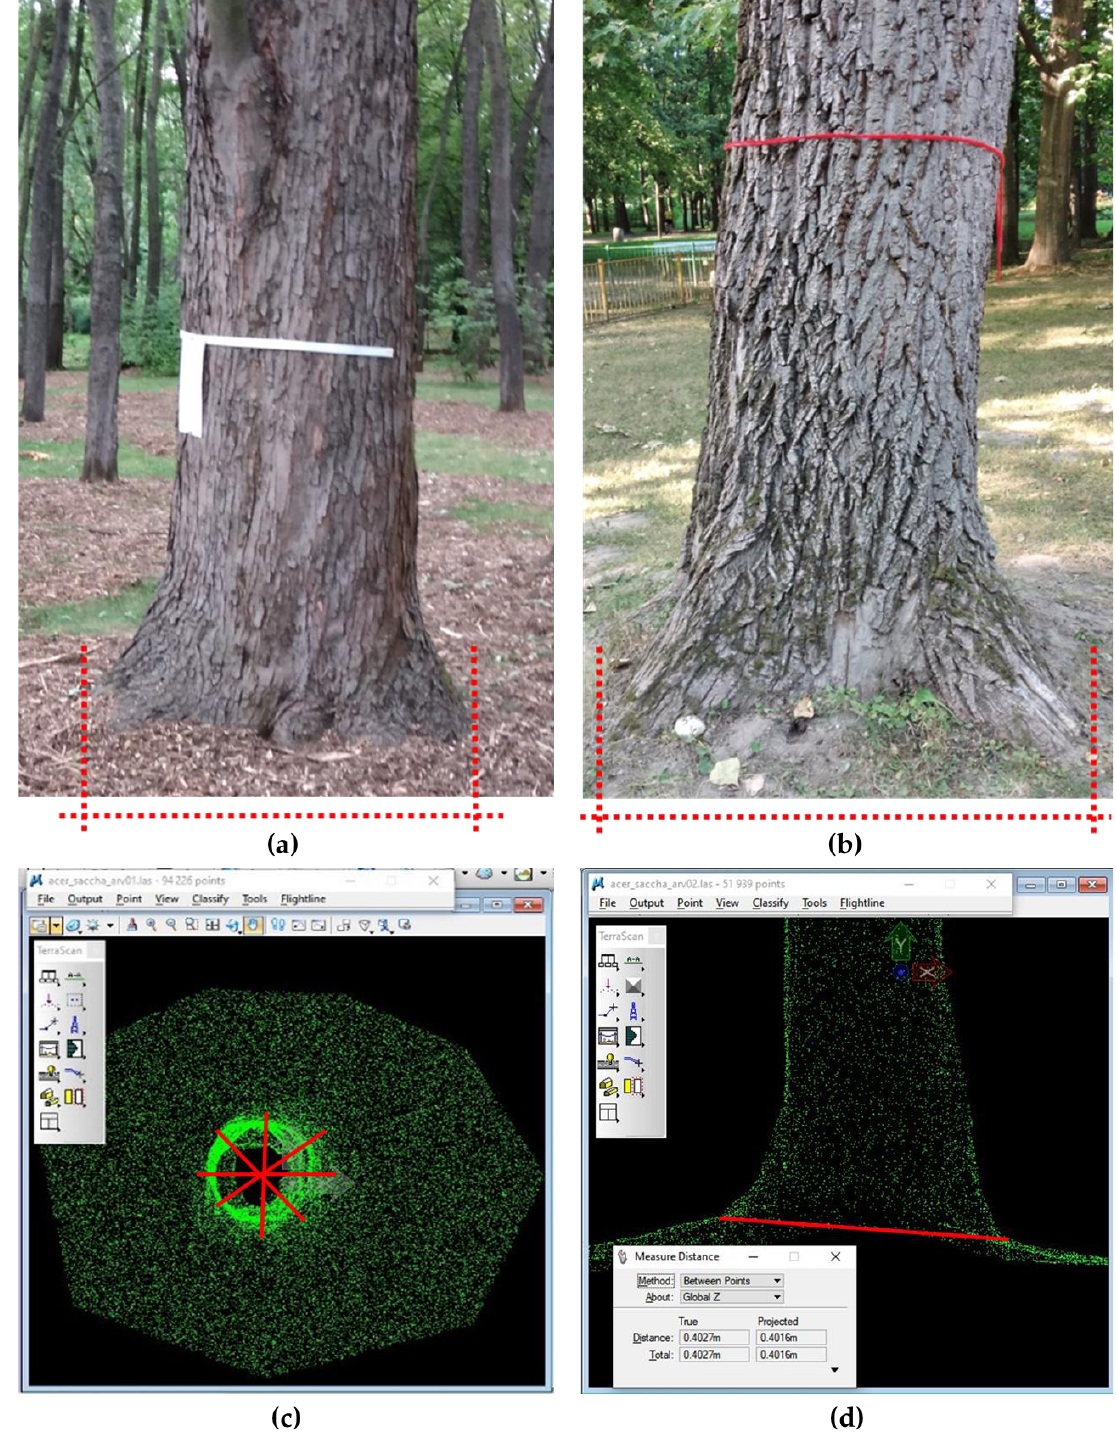
Figure 6. The trunk flare diameter (TFD) limit in two trees of different species: ( a ) Acer saccharinum ; ( b ) Populus balsamifera , and the position of the TFD measurement in different equidistant directions ( c ), and the measurement of TFD ( d ) visualized in a point cloud based on iPad Pro (HLS).